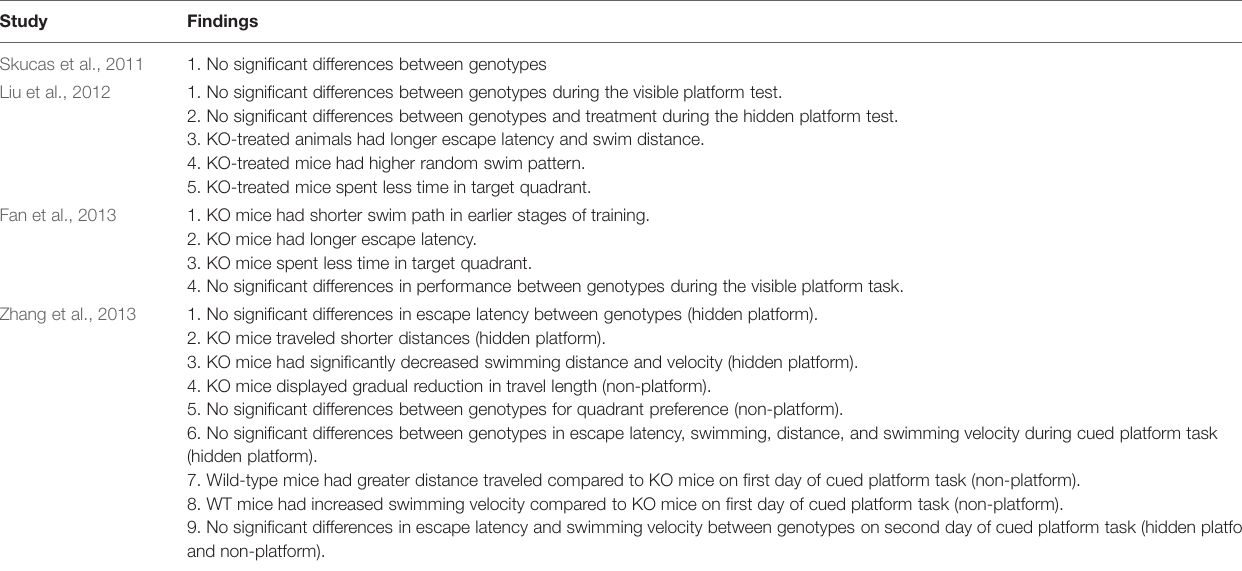
TABLE 2 | Summary of findings from Morris water